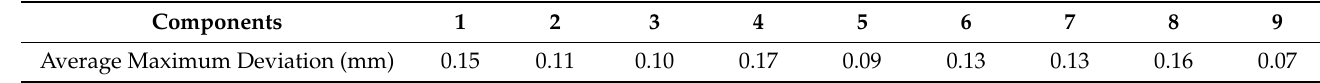
Table 6. Measured deviations of components